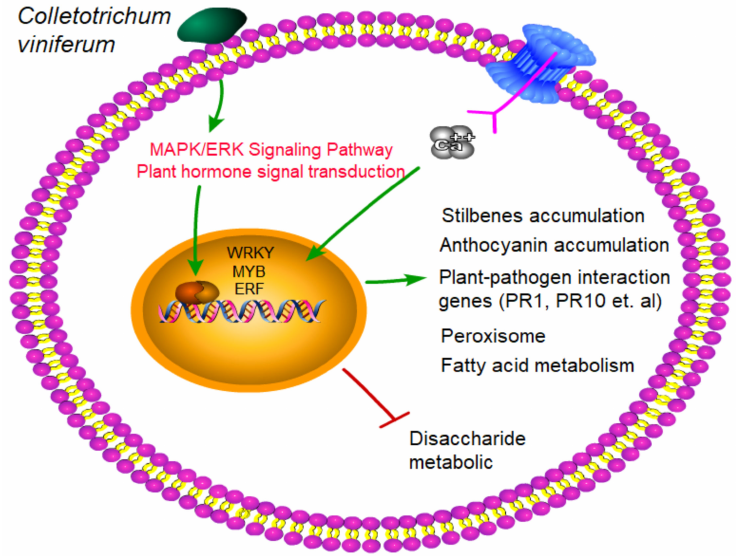
Figure 9. Model of the Colletotrichum viniferum recognition signal transduction pathway.